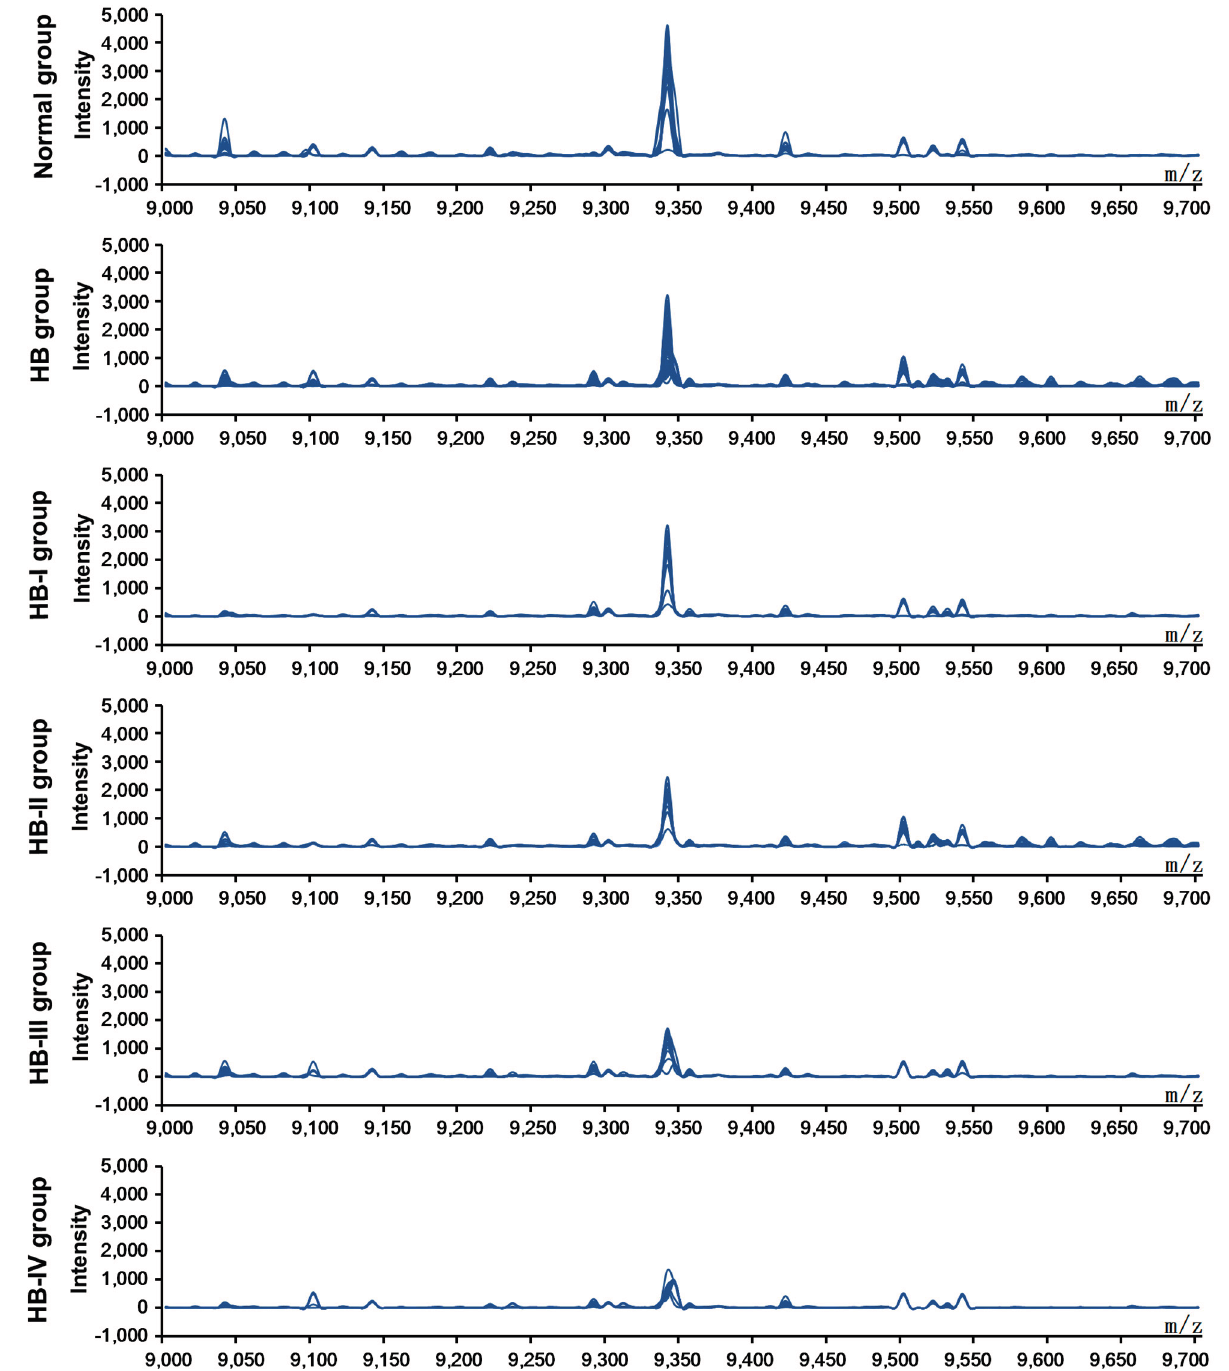
Figure 1. SELDI-TOF-MS analysis of proteins or peptide segments with an m / z of 9348 Da in the normal and HB